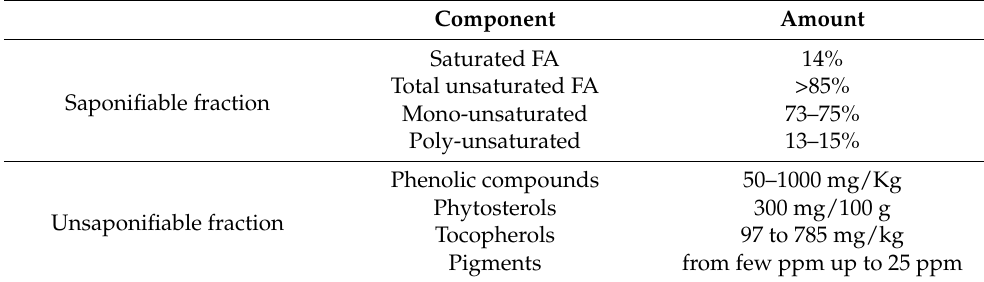
Table 2. Nutritional components of olive